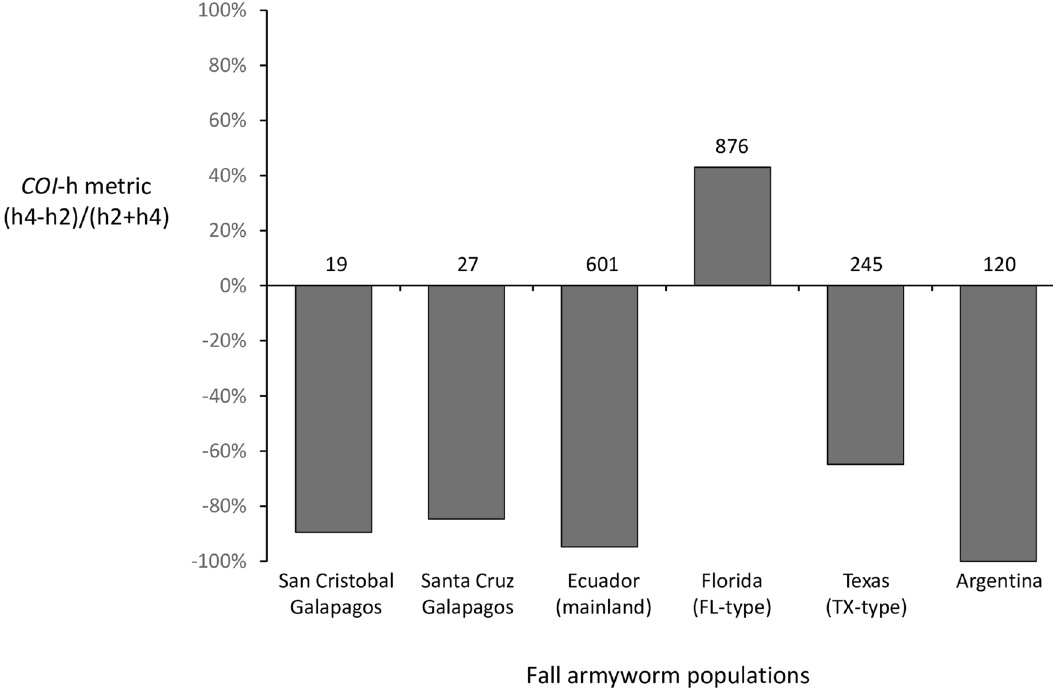
Figure 4. Frequency distributions of the COIB h-haplotype h2 relative to h4 for Ecuador and select locations in the Western Hemisphere. The relative frequency of h4 is calculated by the equation (h4 − h2)/(h2 + h4) presented as a percentage. Numbers indicate the number of COI -CS specimens analyzed. Collections from mainland Ecuador, Florida, Texas, and Argentina were previously described 29,42